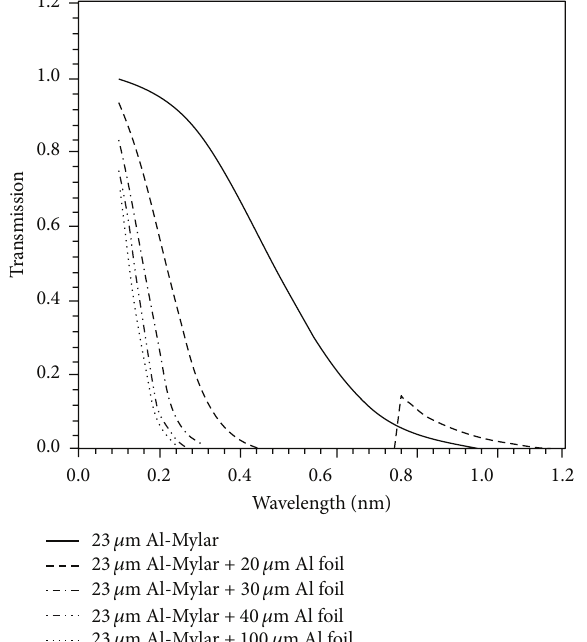
Figure 5: Transmission curves of 23 𝜇 m aluminized Mylar, 23 𝜇 m aluminized Mylar + (20 𝜇 m, 30 𝜇 m, 40 𝜇 m, and 100 𝜇 m) Al foil.